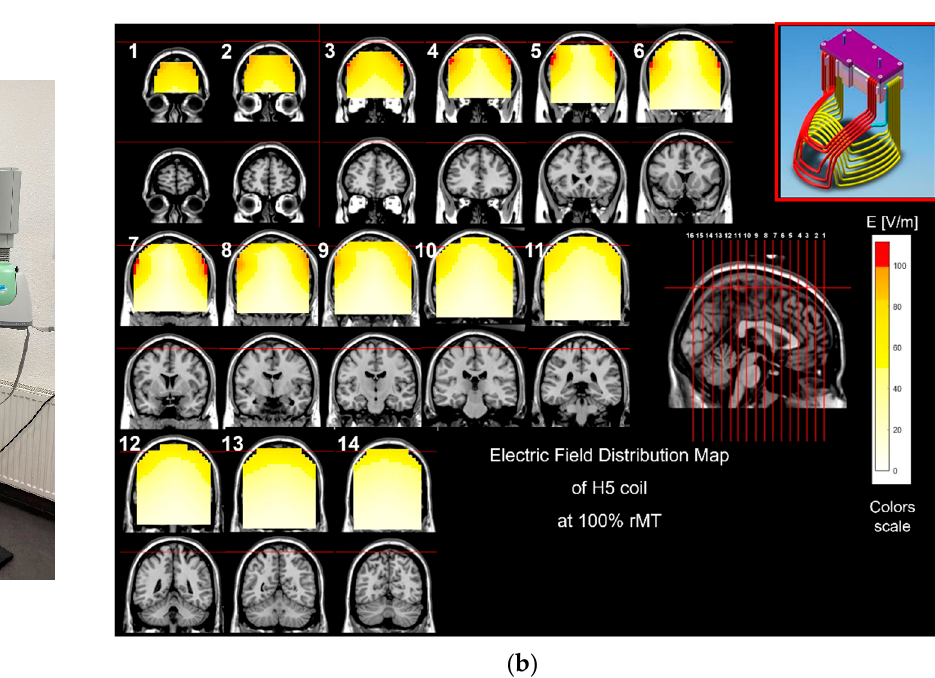
Figure 1. ( a ) Deep TMS system at the Department of Neurology in Kempen with Brainsway H5 Coil CE-marked for Parkinson´s (light green, right) and H2 Coil CE-marked for Alzheimer´s (dark green, left); Magstim Stimulator and Air-cooling. ( b ). Distribution of electric field induced by the H5 coil. The electric field distribution was measured in a model of the human head (15 × 13 × 18 cm) filled with physiologic saline solution. The colored field maps indicate the electric field absolute magnitude in each pixel, for 14 coronal slices, 1 cm apart, along with the appropriate MRI coronal images. The H5 coil was placed over the theoretical frontal cortex of the head model and the field in each pixel was measured using a ‘pick-up’ dipole probe attached to an oscilloscope. The red pixels indicate field magnitude above the threshold for neuronal activation, which was set to 100 V/m based on the average threshold for motor activation of the hand. The field maps are adjusted to obtain 100% of the threshold at a depth of 1.5 cm (Image provided by Brainsway).